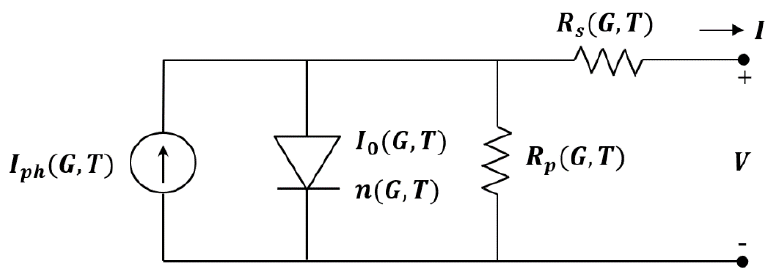
Figure 1. PV-equivalent circuit of a single diode with series and parallel resistance at arbitrary irradiance ( G ) and temperature ( T )